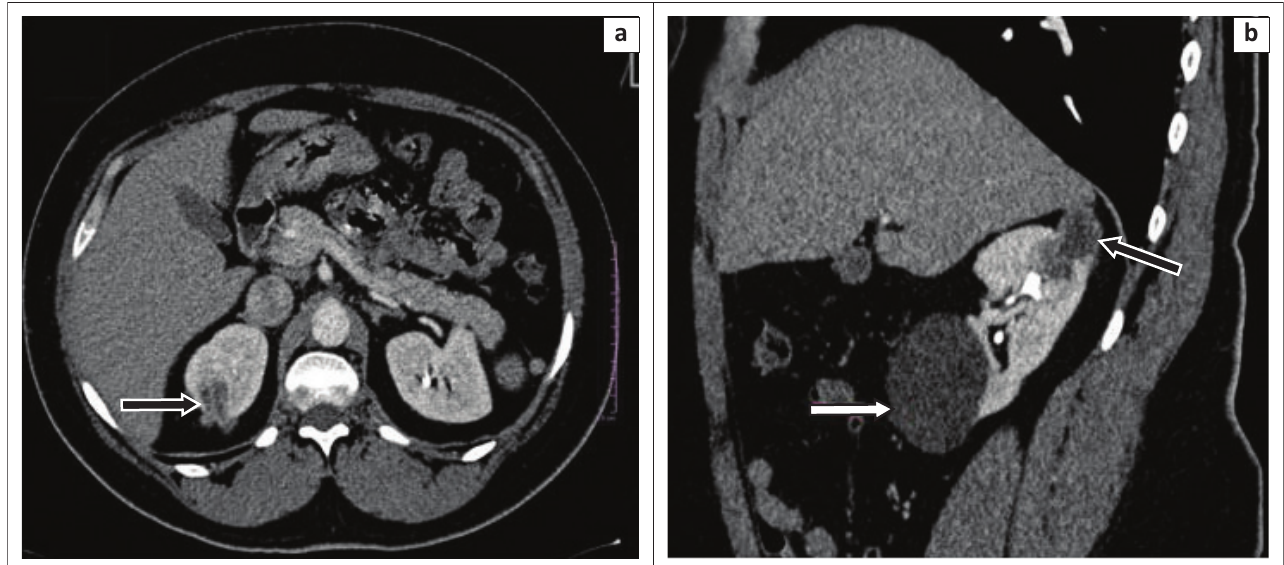
FIGURE 8: Nephrographic phase computed tomography images (a) axial and (b) sagittal demonstrate a multiloculated exophytic complex cystic mass with rim enhancement and enhancing thick septae in the right renal upper pole (black arrow). No associated perirenal fat stranding. Computed tomography diagnosis of cystic renal cell carcinoma was made; histological diagnosis was that of a simple cyst. A further large simple renal cyst is noted in the lower pole of the right kidney (white